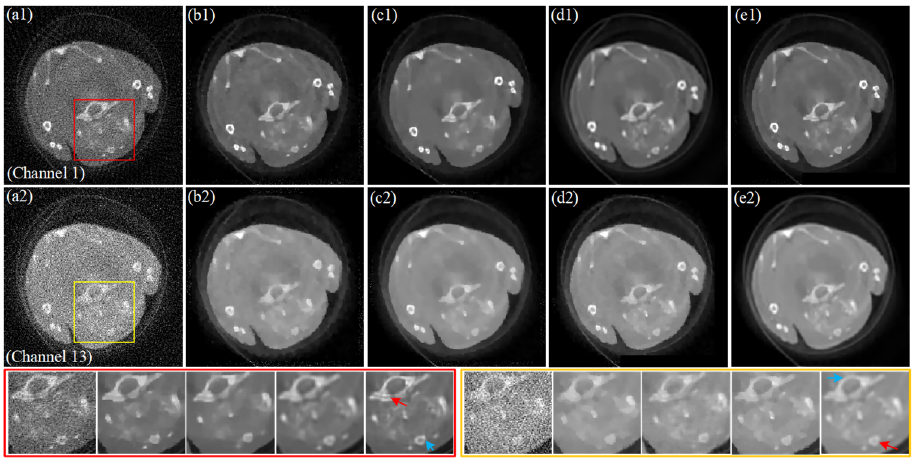
Figure 8. Reconstructed images from 120 projections using different methods. The first and the second rows are the results for channels 1 and 13, respectively. The last row is the corresponding ROIs from ( a1 )–( e2 ) in sequence. From left to right, the columns are FBP ( a ), TV ( b ), TVLR ( c ), TDL ( d ), and our algorithm ( e ). The display windows are [0, 0.1] cm − 1 and [0, 0.08] cm − 1 , respectively.